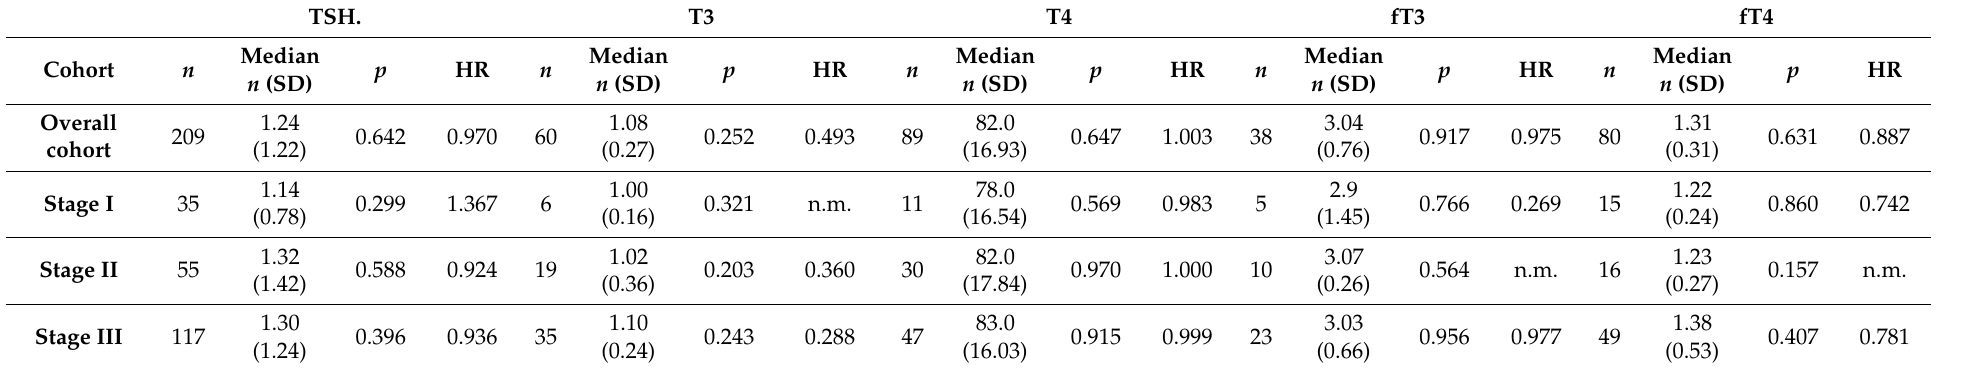
Table 2. Laboratory thyroid parameters and their correlation with the overall survival. Abbreviation: SD—standard deviation. TSH. T3 T4 fT3